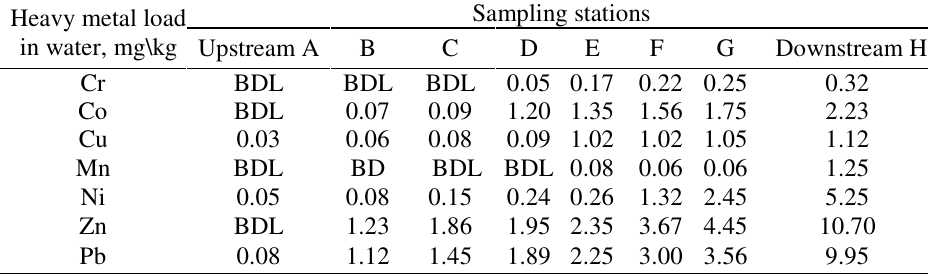
Table 3. Heavy metal concentrations of water (mg/kg) in various sampling